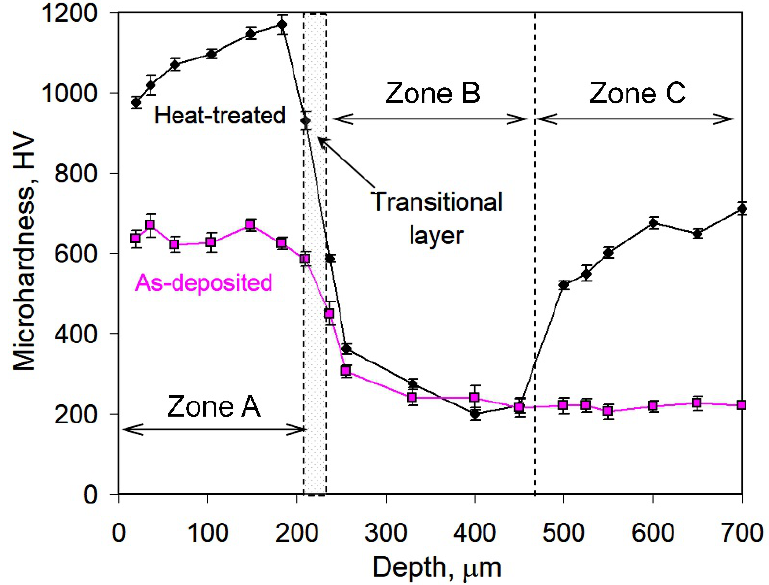
Figure 2. Cross-sectional microhardness profiles of the coated specimens (as-deposited and heat-treated).